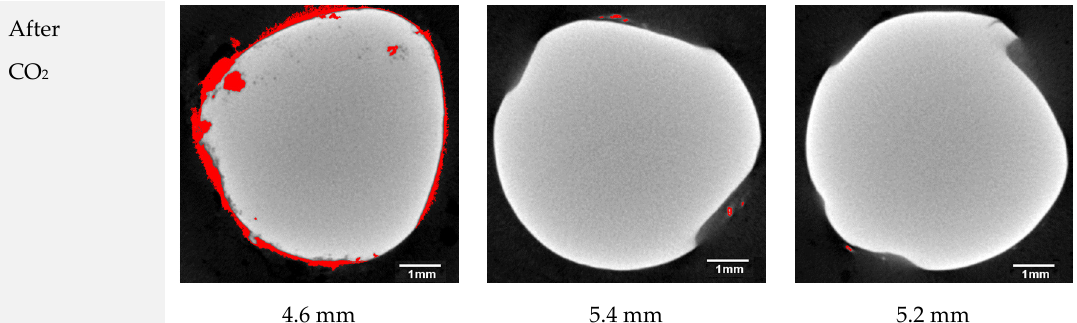
Figure 13. Micro X-ray computer tomography (µXCT) images of steel reinforcement cross sections in the mortar samples with the smallest mortar cover (see values). The red area shows new reaction products with a lower density than non-corroding steel in the transition zone between steel and mortar matrix after leaching and accelerated carbonation ( CO 2 chamber).